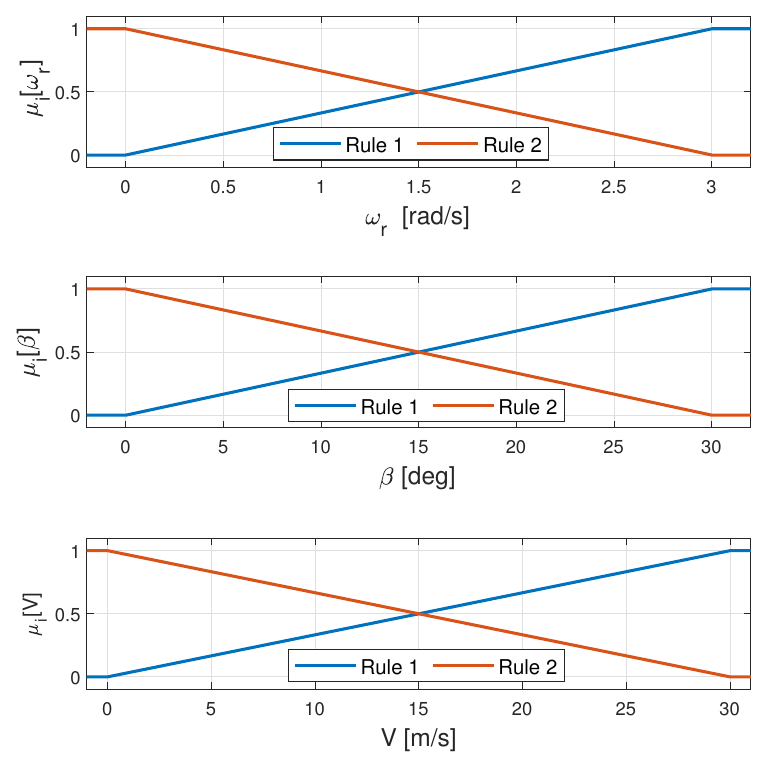
Figure 3. Fuzzy membership